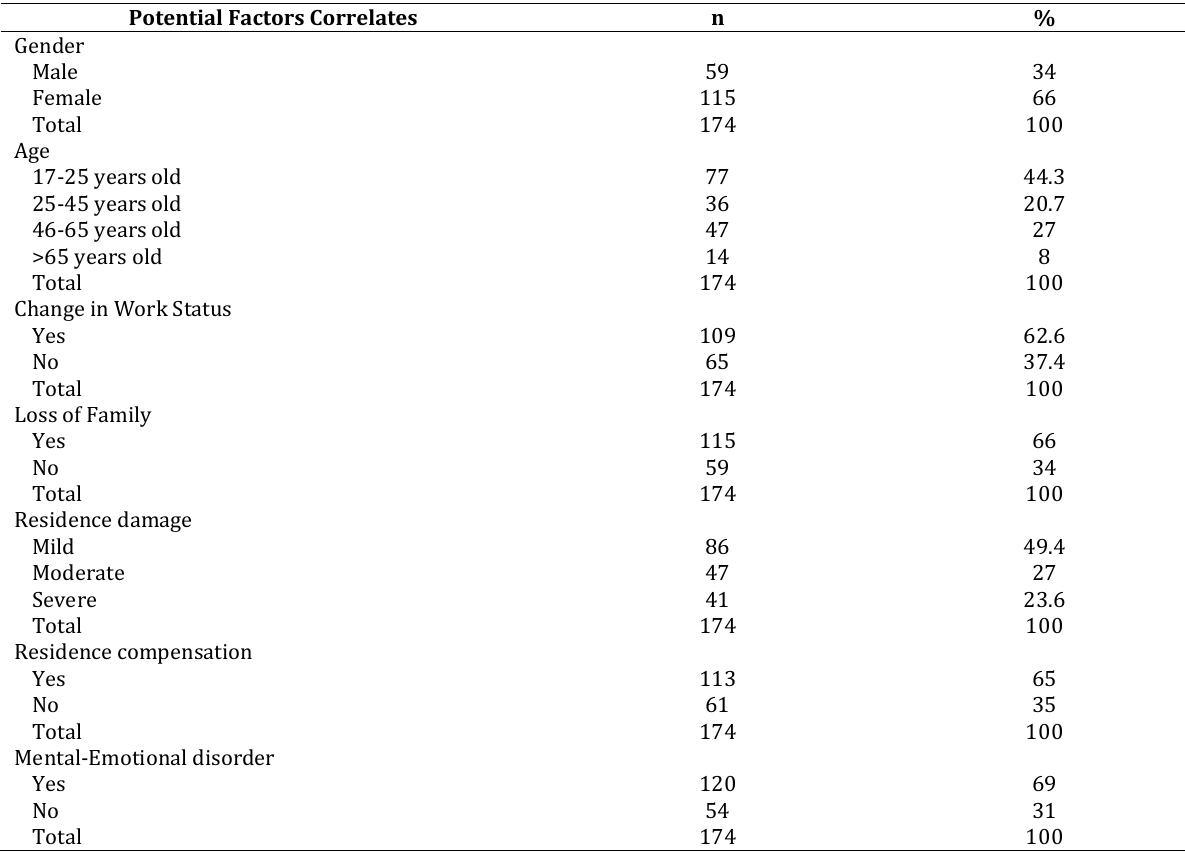
Table 1. Potential Factors Correlated to Mental-Emotional Disorder Potential Factors Correlates